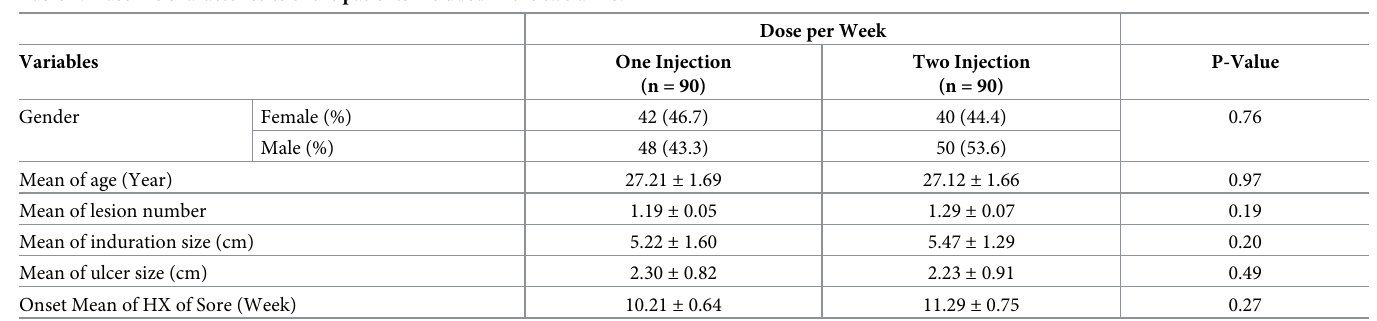
Table 1. Baseline characteristics of the patients included in the two arms.